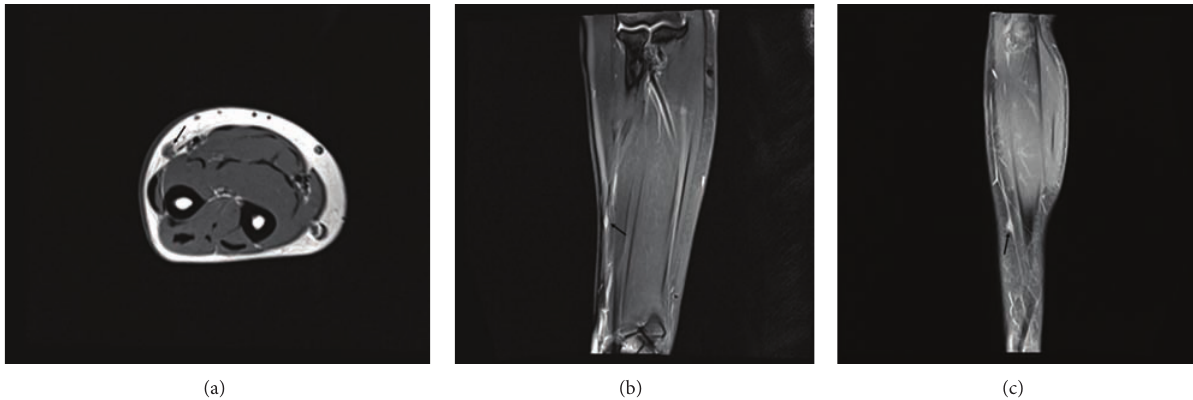
Figure 1: (a) MRI axial T1-weighted image showing an intermediate intensity mass on the subcutaneous layer of the volar-radial aspect of the forearm (arrow). (b) MRI coronal T2-weighted image showing a well-defined high signal mass that is especially prominent in the small vessel (arrow). (c) MRI sagittal image with contrast displaying a homogenous strong enhancement (arrow).